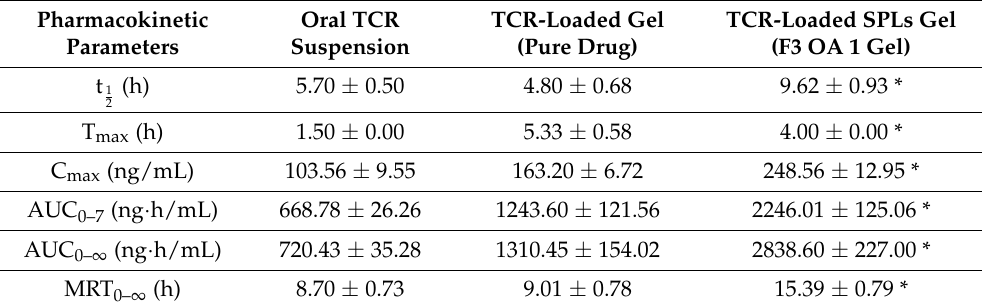
Figure 7. Plasma concentration–time profile of TCR from F3 OA 1 SPLs gel compared to TCR-loaded gel and oral drug suspension in rats. Results ( n = 5) are presented as mean ± SD. Table 5. Pharmacokinetic parameters of TCR after administration of TCR-loaded SPLs gel formula (F3 OA 1 gel), TCR-loaded gel, and TCR oral suspension in rat plasma.